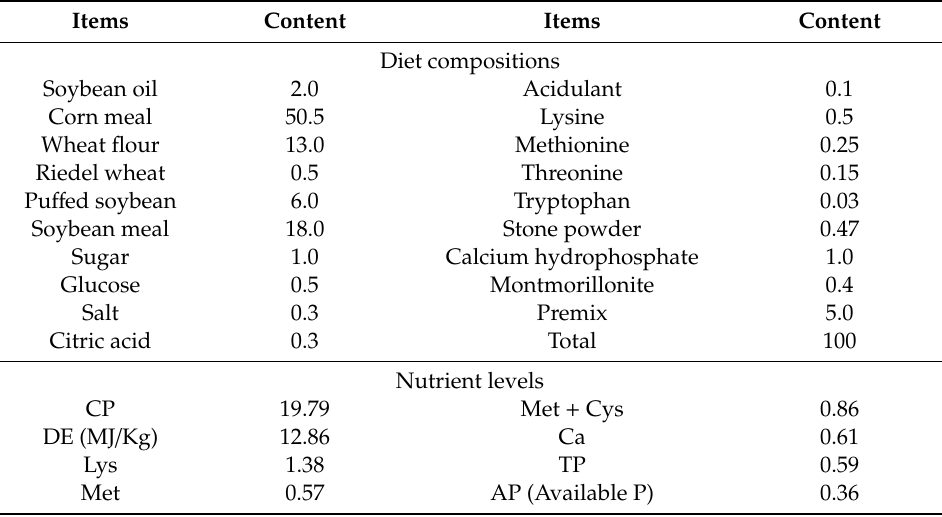
Table 1. Compositions and nutrient levels of basal diet